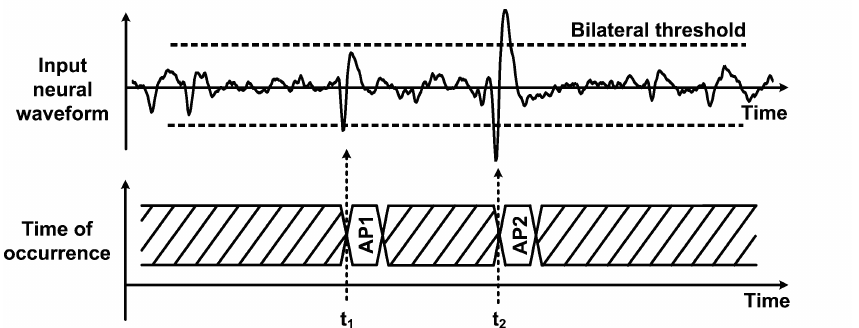
Figure 4. A data reduction scheme employing a bilateral threshold function. In such scheme, action potentials are detected upon threshold crossing and then tagged with their respective time of